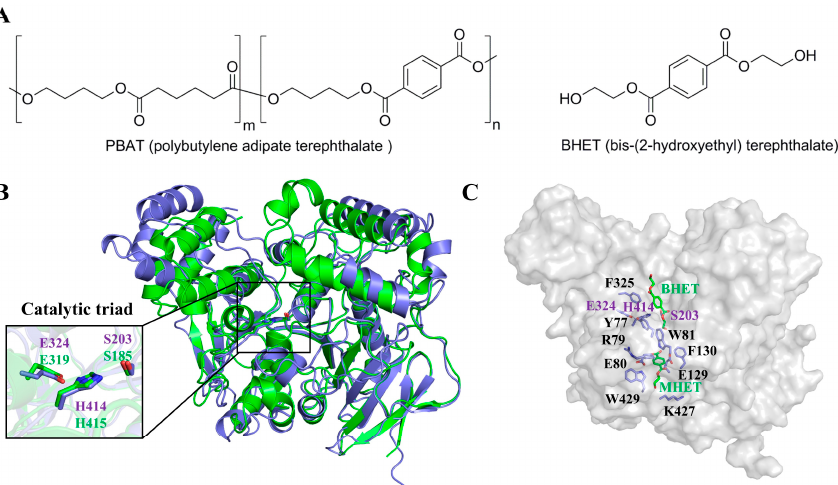
Figure 5. Comparison of Tcca structure and identification of substrate binding tunnel. ( A ) Illustrations of TCCA substrates PBAT and BHET. ( B ) Superimposition of modeled Tcca with TfCa crystal structure. The modeled structure of Tcca is in purple, and the crystal structure for TfCa (PDB: 7W1K) is in green. The catalytic triad of Tcca (S203 − E324 − H414) superimposed well with that of TfCa (S185 − E319 − H415). ( C ) Alignment of Tcca to TfCa with bound ligands. The modeled Tcca structure is shown as the surface, the residues around the substrate binding channel of Tcca are shown in sticks in purple, and the bound substrates BHET and MHET are in green.